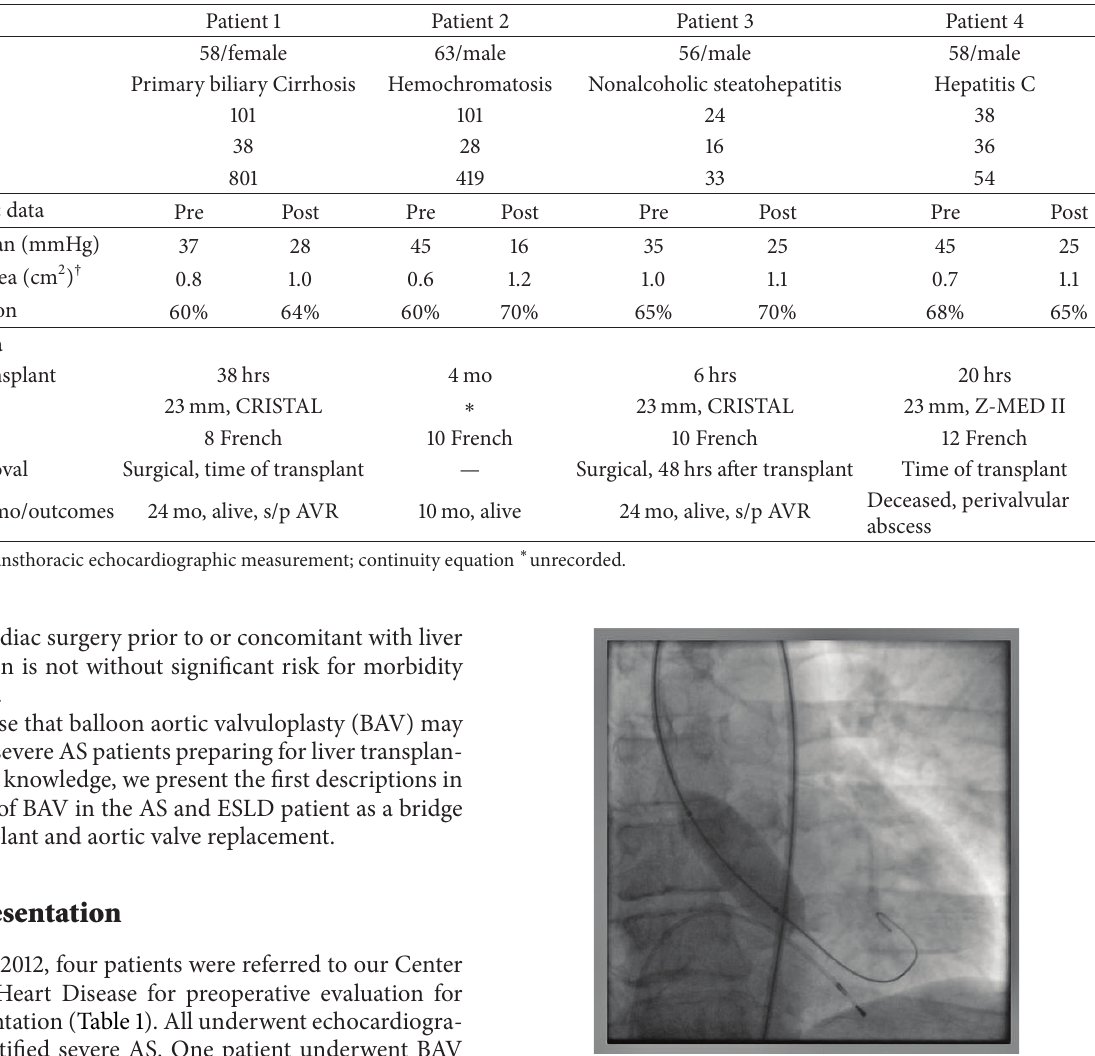
Table 1: Patient and procedural characteristics before and after valvuloplasty.